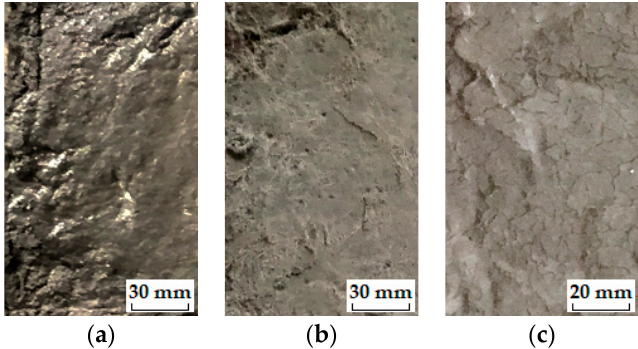
Figure 15. The surface appearance of typical ECC mixtures: ( a ) Mix. 6 after 75 cycles; ( b ) Mix. 4 after 350 cycles; ( c ) Mix. 9 after 400 cycles. 350 cycles; ( c ) Mix. 9 after 400 cycles.